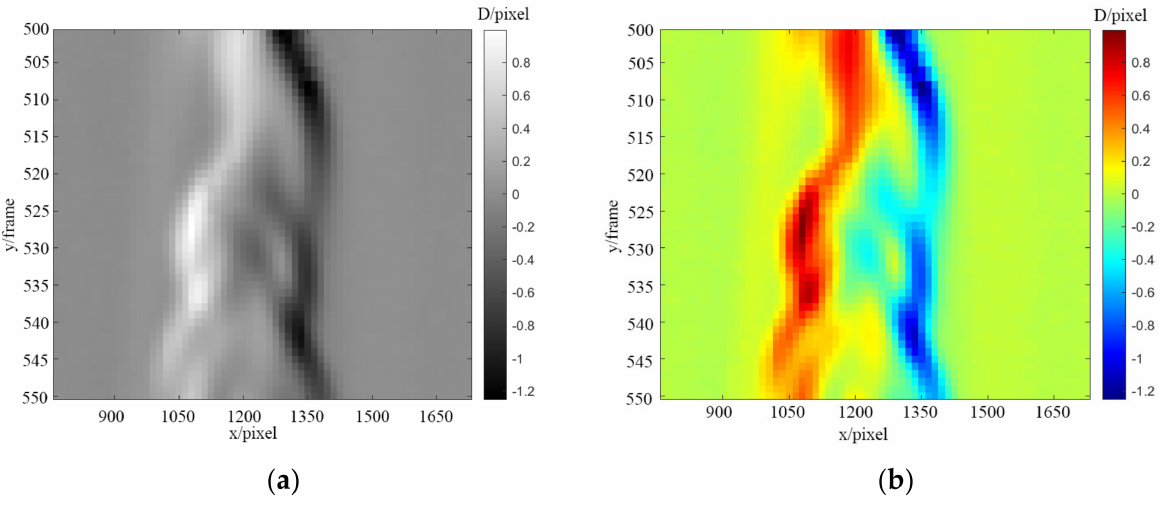
Figure 13. Time series horizontal baseline stacking diagram. ( a ) A grayscale image, and ( b ) a jet color image.